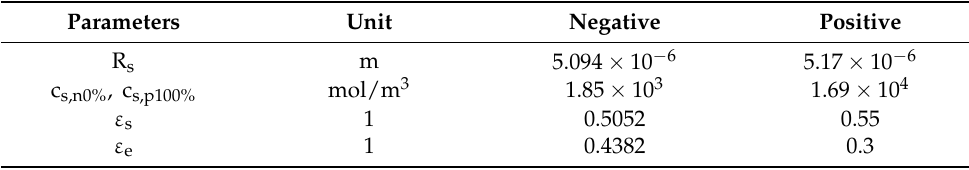
Table 5. Parameter identification